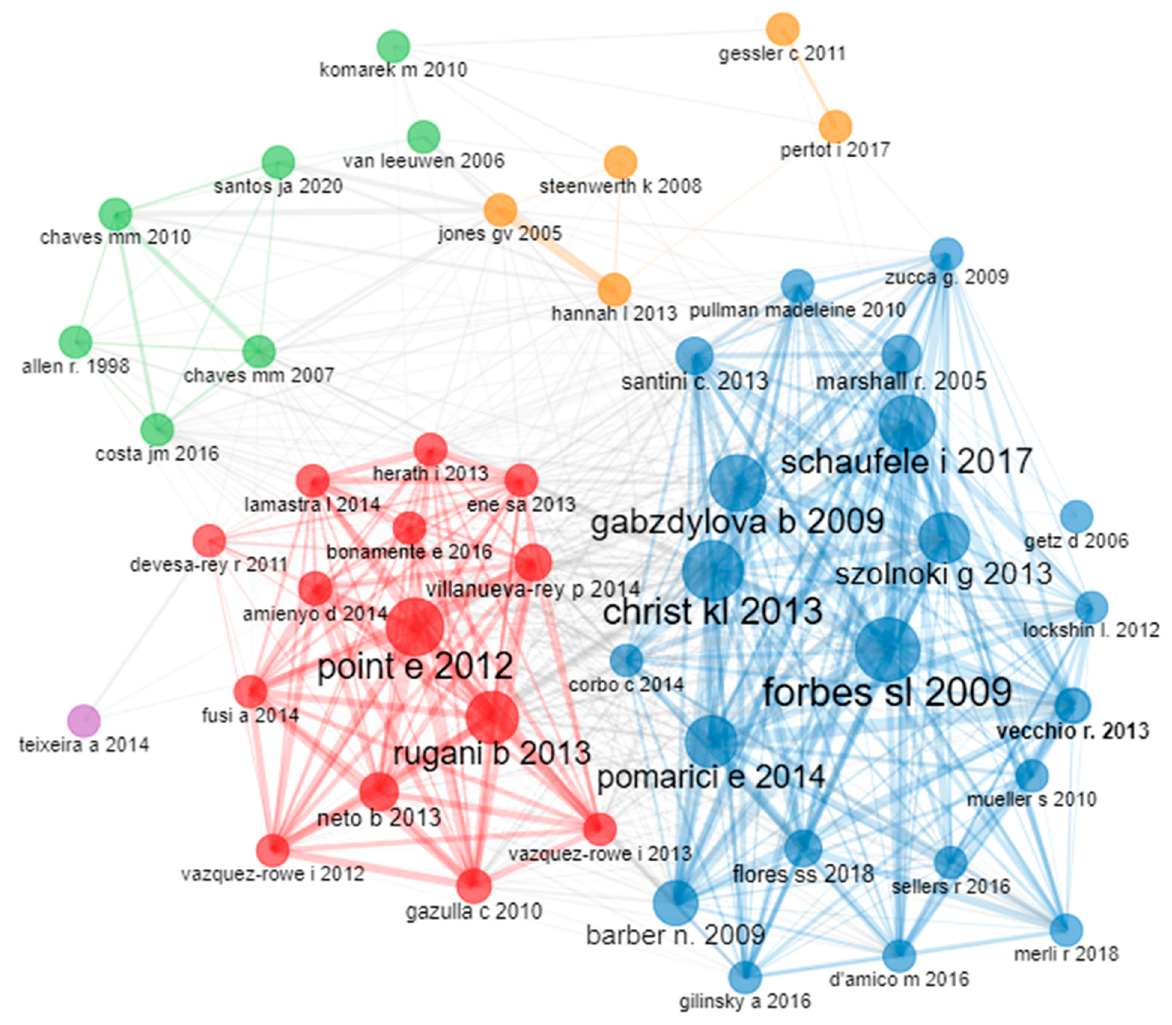
Figure 7. Co-citation network .